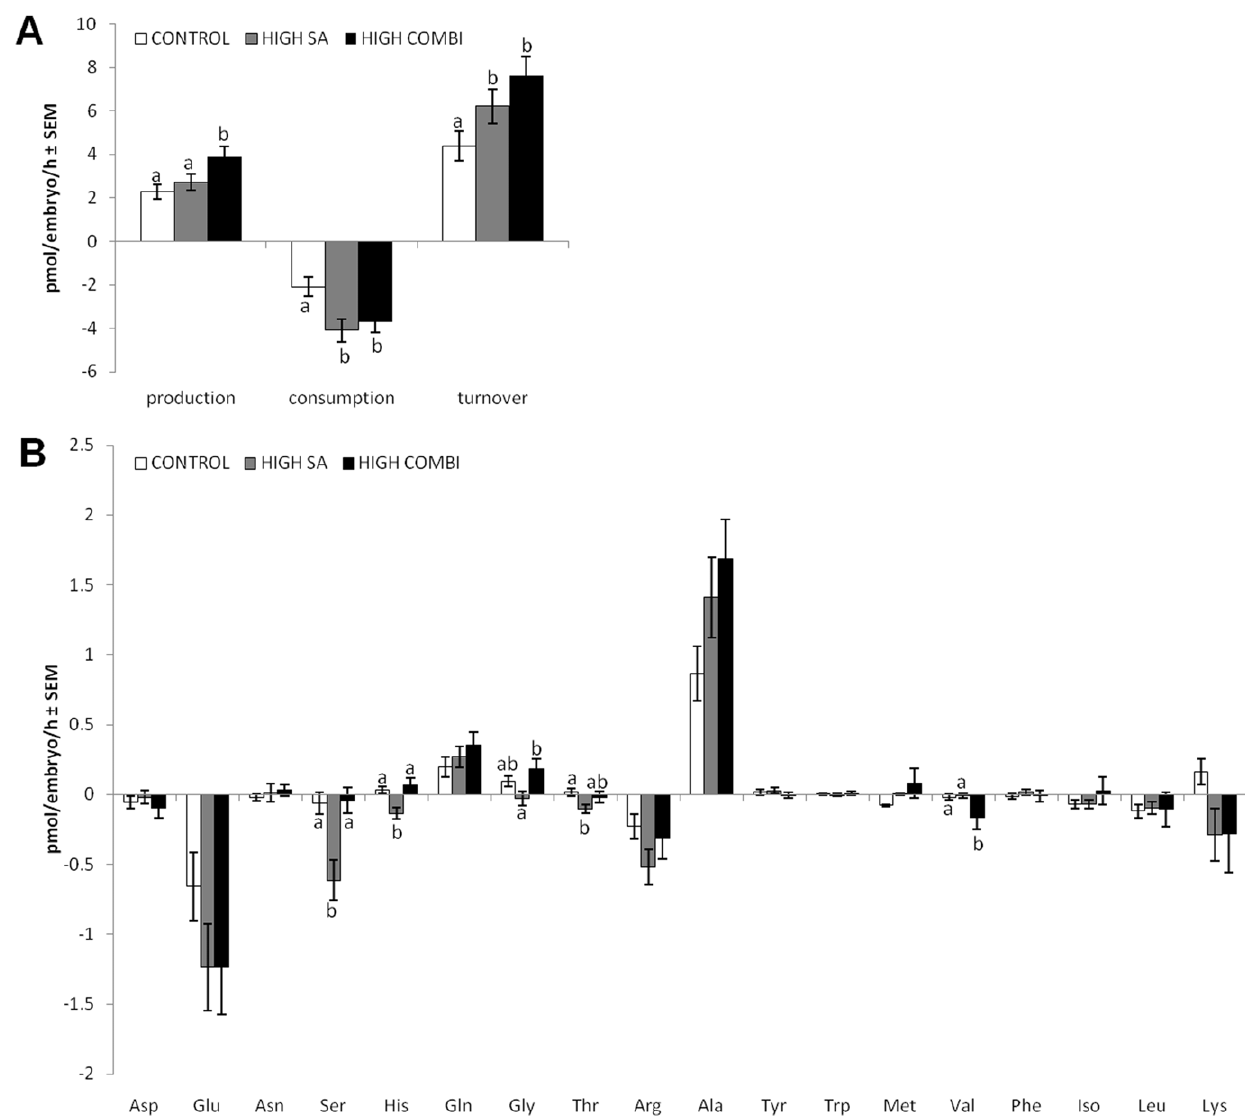
Figure 2. Amino acid metabolism of blastocysts originating from NEFA-exposed oocytes is compromised. A. Amino acid ‘turnover’ of day 7 blastocysts as calculated by summing all amino acids produced and consumed on a per-embryo basis. Comparison was done between blastocysts (n=135; three replicates) derived from oocytes matured under control, HIGH SA and HIGH COMBI conditions. B. Overall mean profiles of individual amino acids by blastocyst in the three treatments. Bars with different superscripts are significantly different between treatments (P , 0.05).